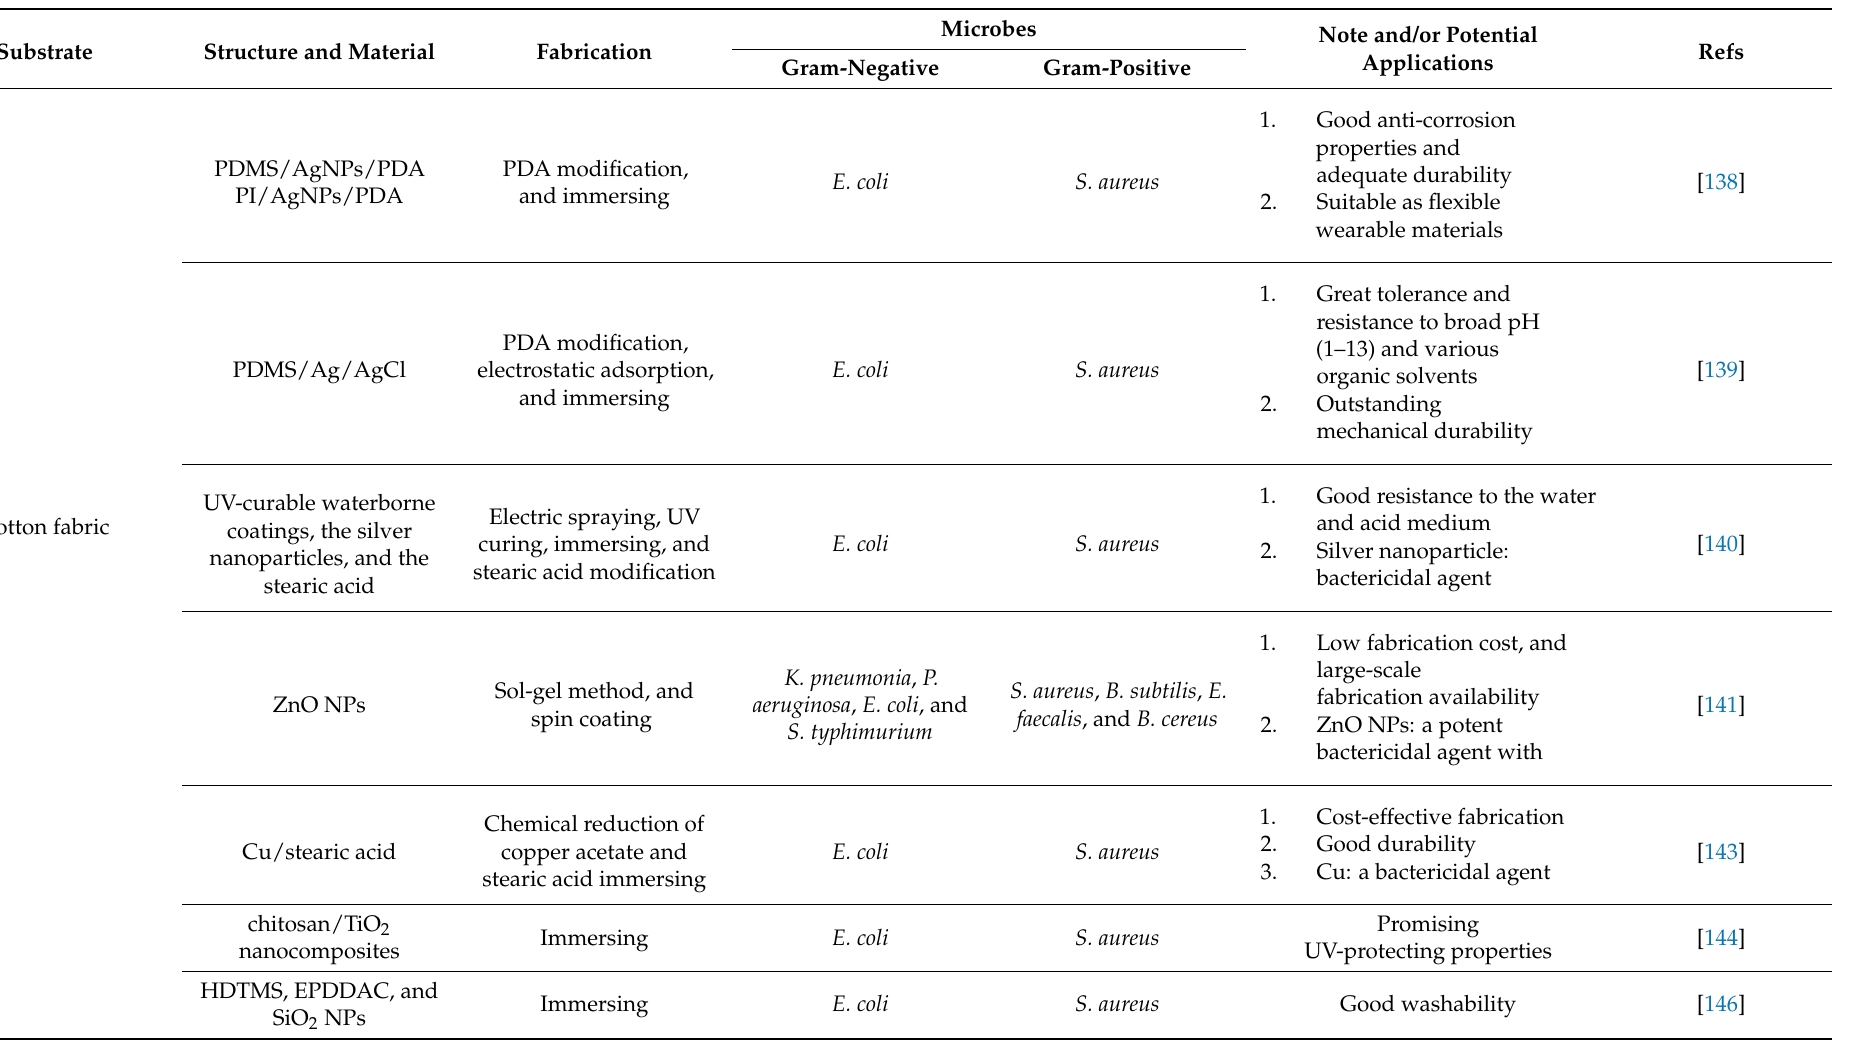
Table 2. Summary of superhydrophobic